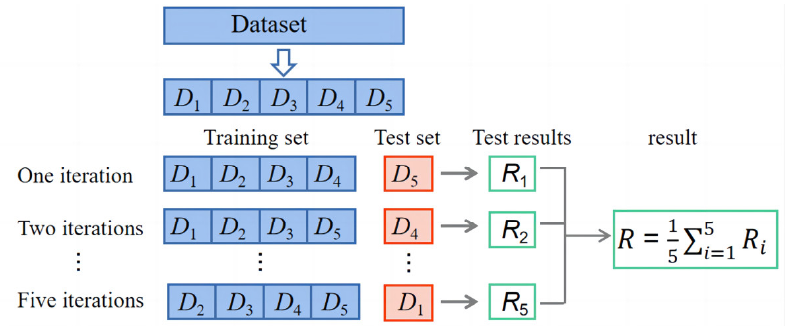
Figure 8. Five-fold cross-validation diagram.